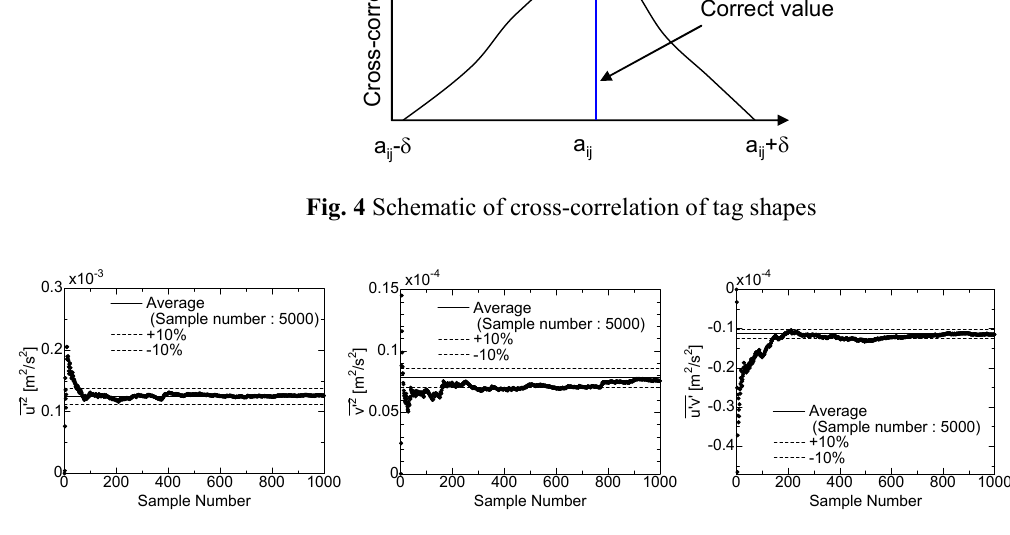
Fig. 5 Effects of sample number on averaged values ( y = 3.0